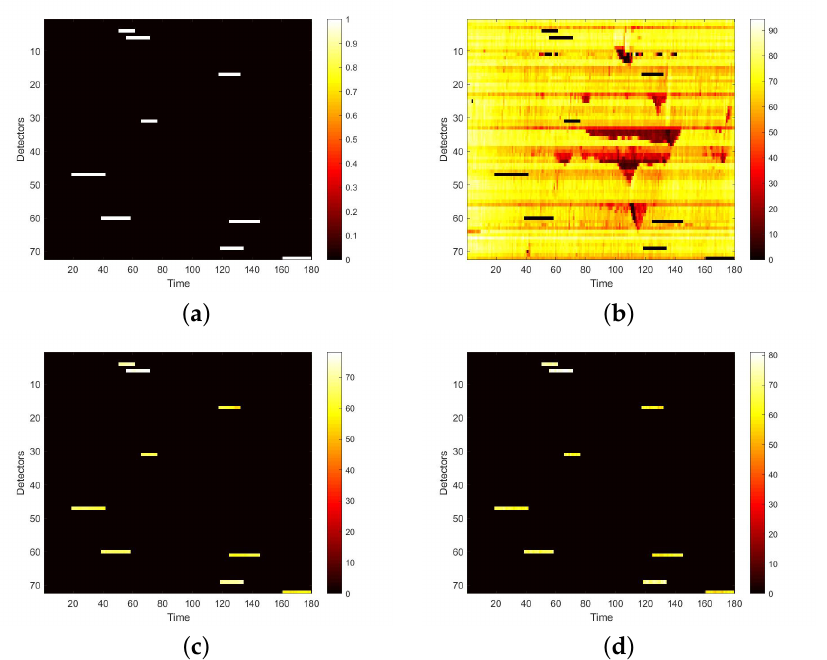
Figure 12. Speed matrices of Neihuan elevated highway (the 6thday of testset) with strip damage visualized as heat maps. ( a ) Mask matrix visualized as a heat map. ( b ) Damaged speed matrix visualized as a heat map. ( c ) Repaired speed matrix visualized as a heat map. ( d ) Real speed matrix visualized as a heat map.